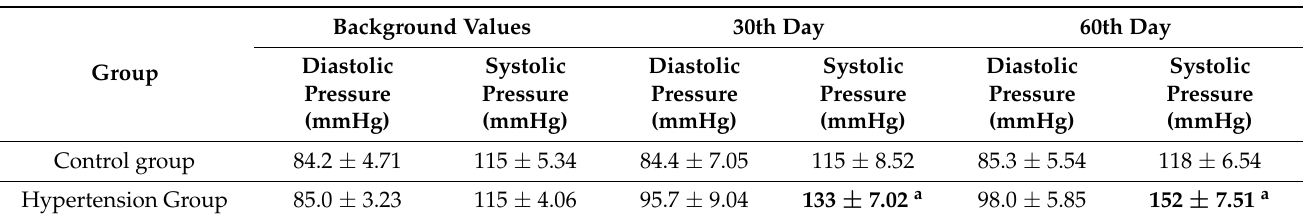
Table 1. BP data of the control and hypertensive groups in different intervals during the animal modeling